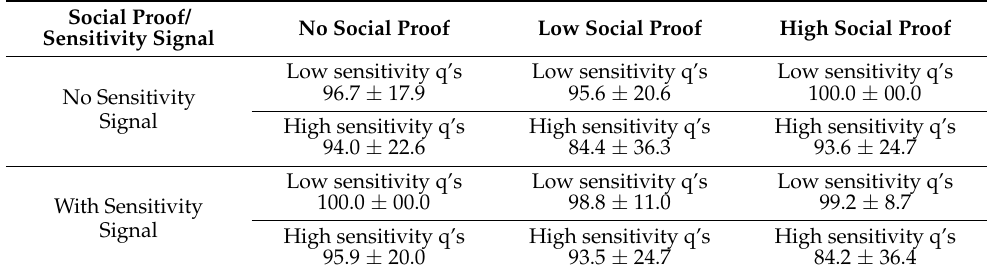
Table 7. Response Rate Per Nudge Combination and Question Sensitivity.